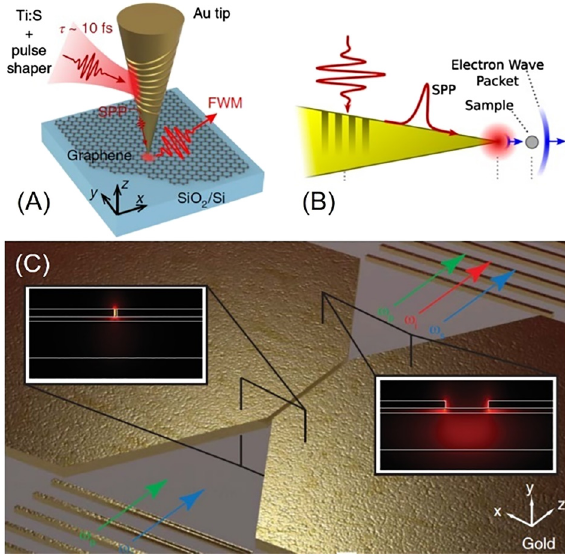
Figure 2: (A) A gold cone with engraved grating is illuminated with the femtosecond pulse to generate a localized hot-spot, used to probe the nonlinear properties of graphene. (B) Nanofocusing of electromagnetic radiation into the plasmonic slot waveguide allows efficient on-chip four-wave mixing. (C) Spatially and temporally resolved electron pulses are generated by nanofocusing of grating- coupled ultrashort laser pulse along the gold taper. Figure repro- duced with permission from (A) ref. [22], © 2019 Springer Nature; (B), ref. [28], © 2017 AAAS; (C) ref. [30], © 2015